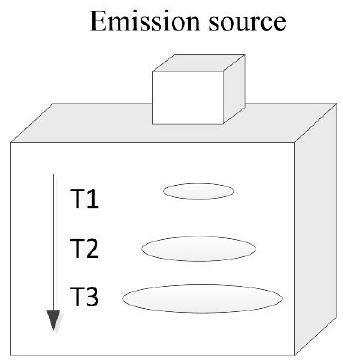
Figure 3. The electromagnetic wave waveform generated by the emission source.